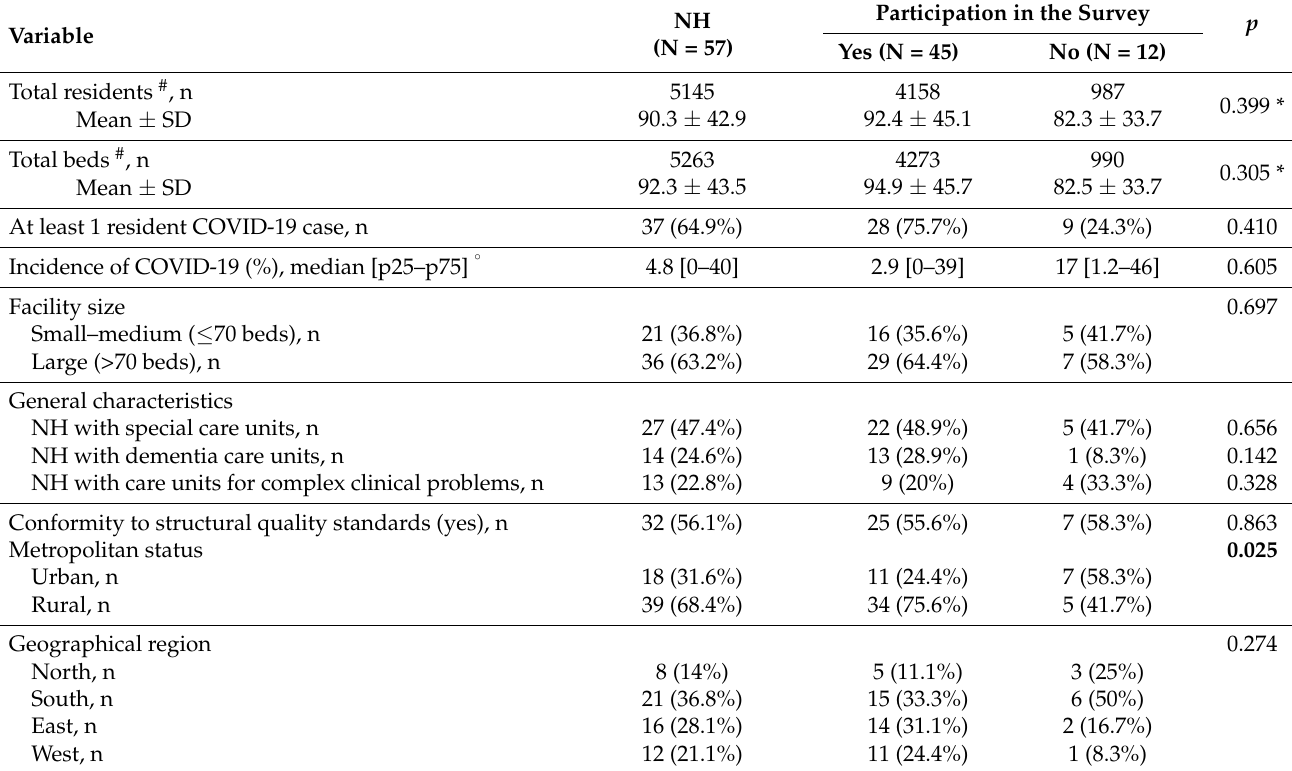
Table A1. Main characteristics of the nursing homes (NH) in the province of Trento, by participation in the infection prevention and control